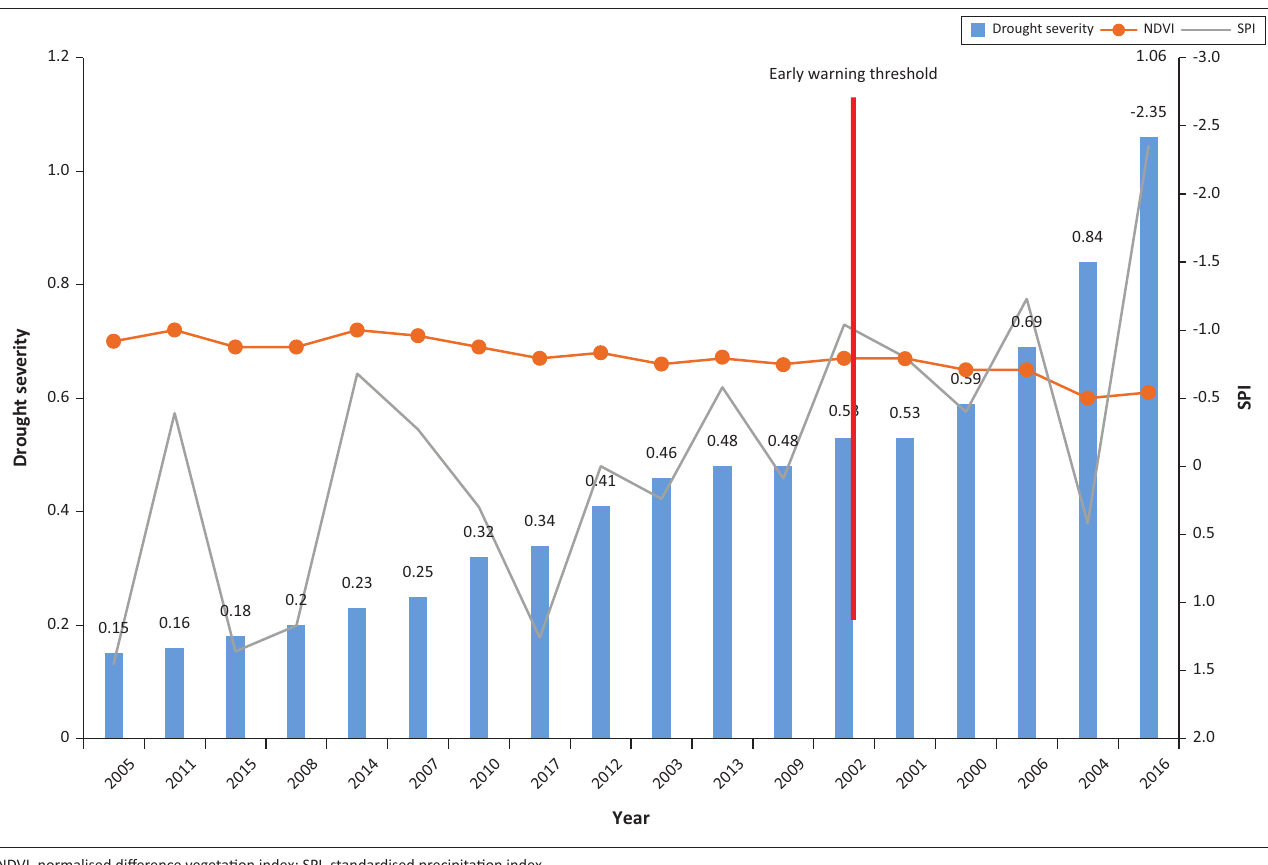
NDVI, normalised difference vegetation index; SPI, standardised precipitation index. FIGURE 5: Determination of Y (drought